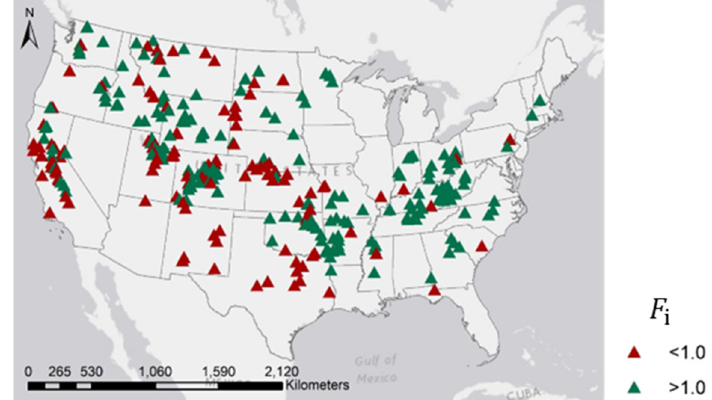
Figure 4. The expansion feasibility metrics of reservoir.